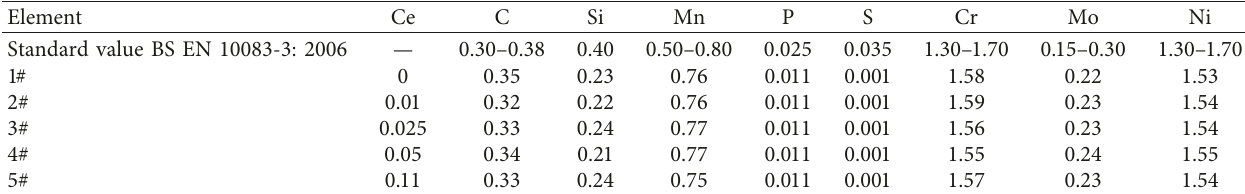
Figure 1: Outages and downtime weights of wind turbine Table 1: Chemical compositions of 34CrNiMo6 steel (mass fraction, %).